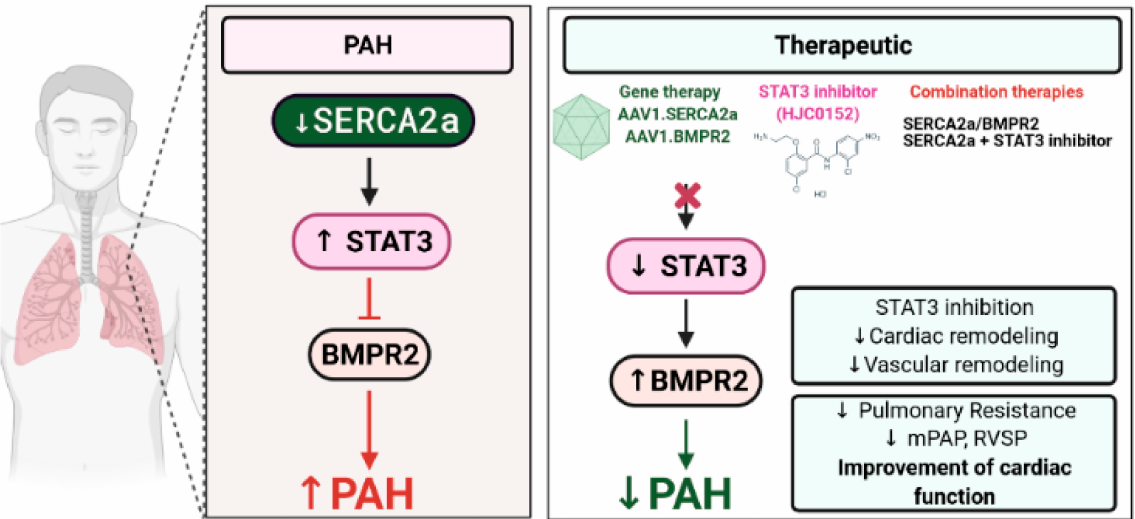
Figure 8. Schematic representation of the molecular pathway by which SERCA2a regulates BMPR2 in pulmonary vascular cells and inhibits PAH. Combination therapy using the STAT3 inhibitor HJC0152 enhanced SERCA2a-mediated effects to attenuate pulmonary vascular remodeling and restore RV function. Created with BioRender.com.